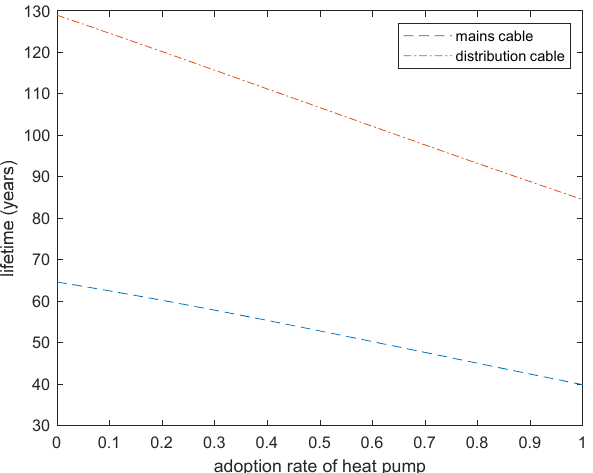
Figure 9. Impact of adoption rate of ASHP on the life of the mains’ cable.